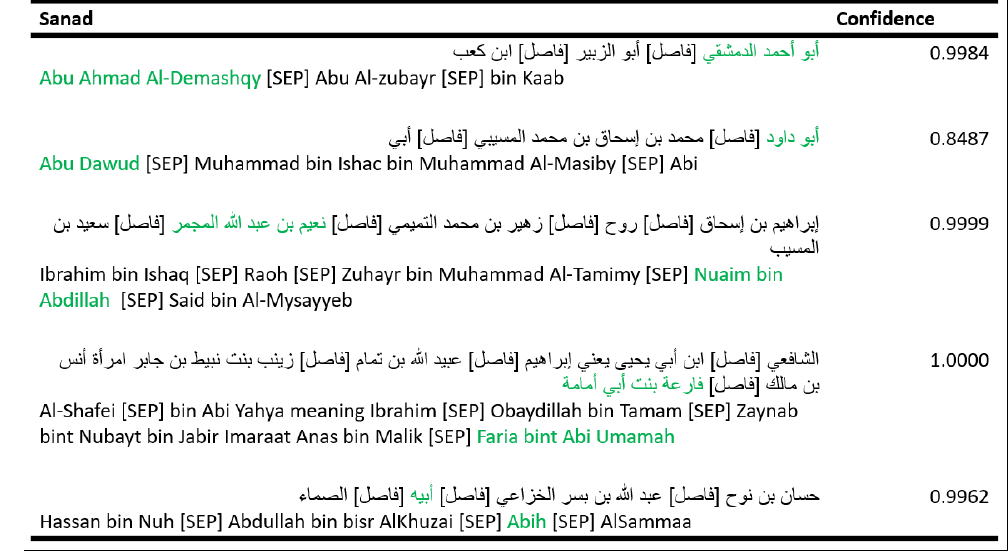
Figure 9. Examples of true predictions for narrators marked in green and the model’s confidence in the prediction.